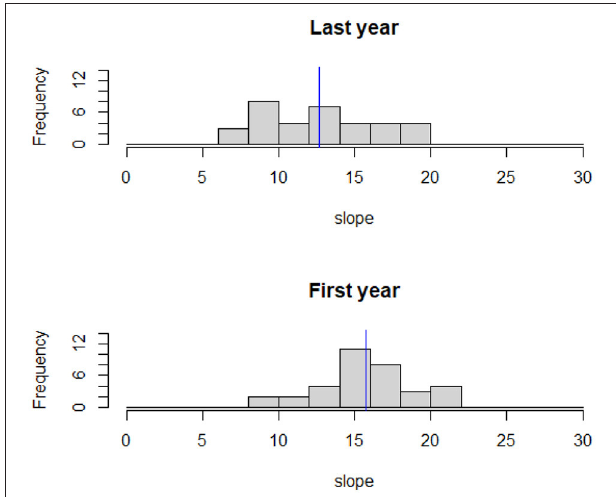
FIGURE 5 | The distribution of the average slope (in degrees) for the 90% isopleth of individual home ranges. The blue line represents the study area mean slope. Mean slope was significantly lower during the last year of tracking compared to the first (weighted t -test: p < 0.001).